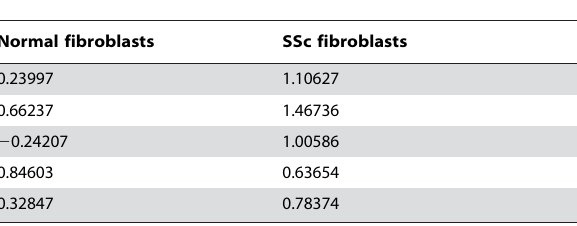
Table 1 . Eigenvalues of the transition matrix A of the state- space model for the genes in a regulatory network responding to silica in cultured human normal and SSc